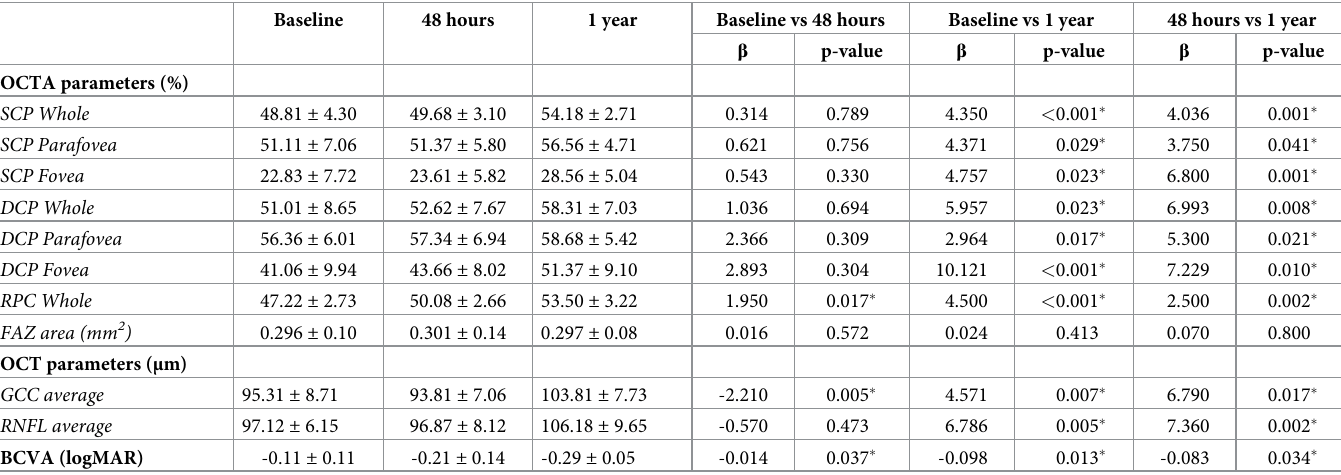
Table 1. Differences in OCTA, SD-OCT and BCVA before and each time point after surgery via endoscopic endonasal approach.